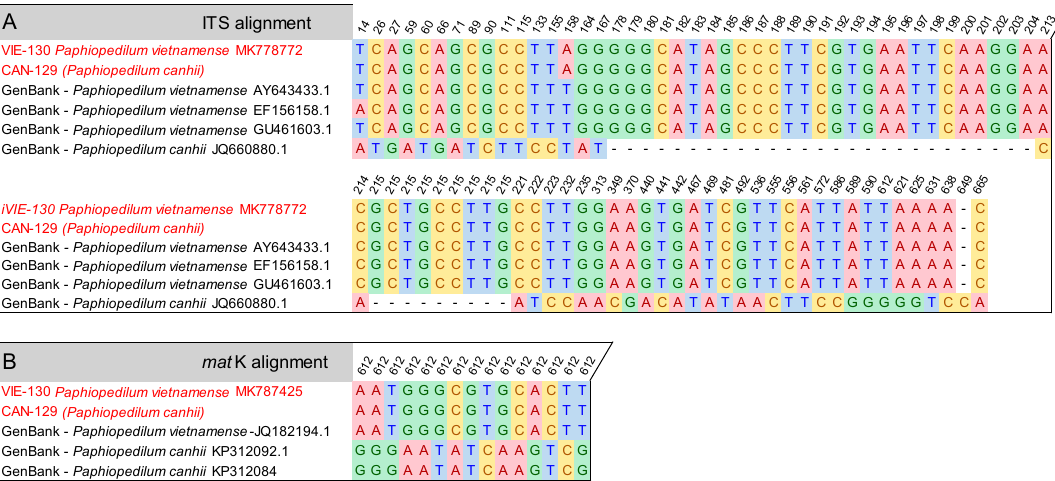
Figure 4. Nucleotide polymorphism of sample CAN-129 in comparison with referenced sequences from GenBank of Paphiopedilum vietnamense and Paphiopedilum canhii species. ( A ): alignment file using ITS sequences; ( B ): alignment file using mat K sequences. (Color accession: sample from our study. Black accession: reference accession from GenBank. Color of nucleotides represent four different nucleotides, i.e., A, T, G, C. Number above: site of variation on alignment data).